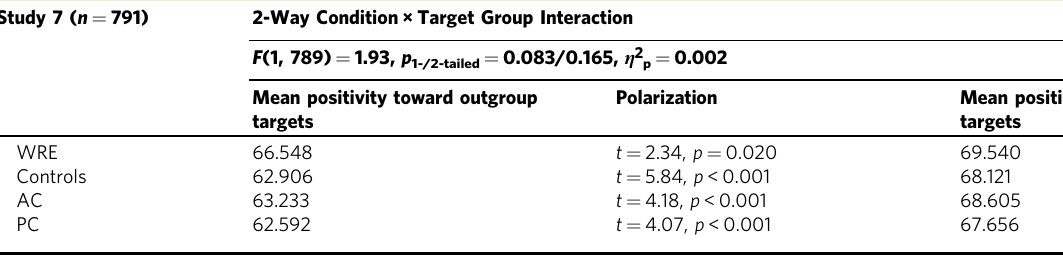
Table 1 Study 7: attitude polarization as a function of Conditions and political orientation. Study 7 ( n =